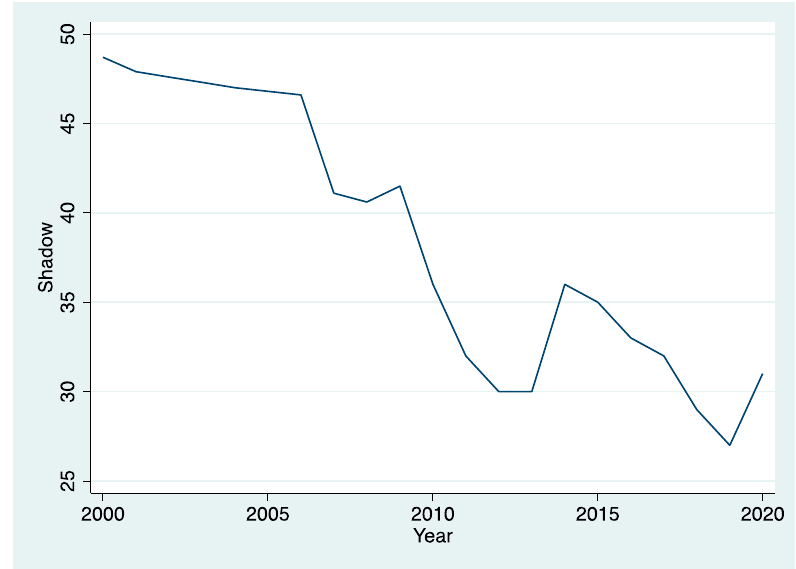
Figure 1. Share of the shadow economy in the total economy over time.